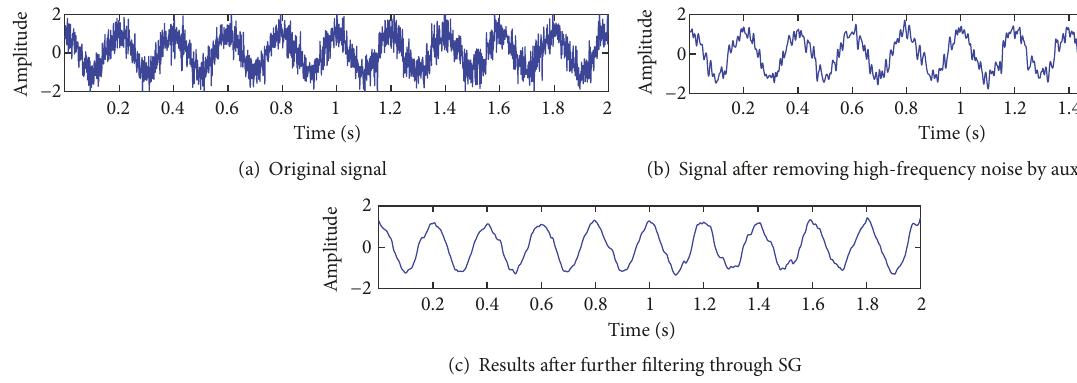
Figure 1: Noise-containing signal and noise-reduced signal.